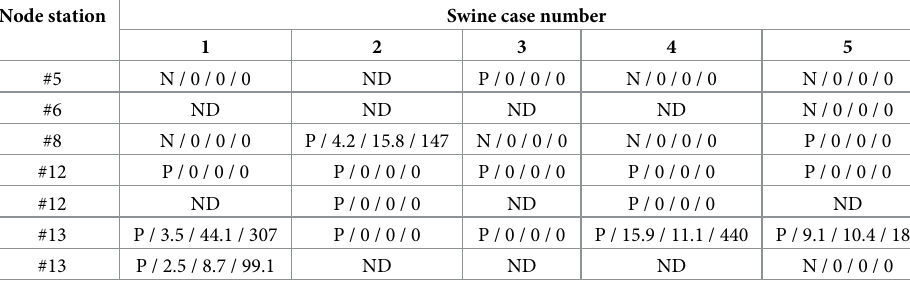
Table 2. Topographical distribution of sentinel lymph nodes in the five swine. Node station Swine case number 1 2 3 4 5 #5 N / 0 / 0 / 0 ND P / 0 / 0 / 0 N / 0 / 0 / 0 N / 0 / 0 / 0 #6 ND ND ND ND N / 0 / 0 / 0 #8 N / 0 / 0 / 0 P / 4.2 / 15.8 / 147 N / 0 / 0 / 0 N / 0 / 0 / 0 P / 0 / 0 / 0 #12 P / 0 / 0 / 0 P / 0 / 0 / 0 P / 0 / 0 / 0 P / 0 / 0 / 0 P / 0 / 0 / 0 #12 ND P / 0 / 0 / 0 ND P / 0 / 0 / 0 ND #13 P / 3.5 / 44.1 / 307 P / 0 / 0 / 0 P / 0 / 0 / 0 P / 15.9 / 11.1 / 440 P / 9.1 / 10.4 / 184 #13 P / 2.5 / 8.7 / 99.1 ND ND ND N / 0 / 0 / 0 Data are shown in the following sequence: Indocyanine green hotspot (P, positive; N, negative)/magnetic field during laparoscopic surgery ( μ T)/magnetic field of the extracted lymph nodes ( μ T)/iron content ( μ g). ND: Not